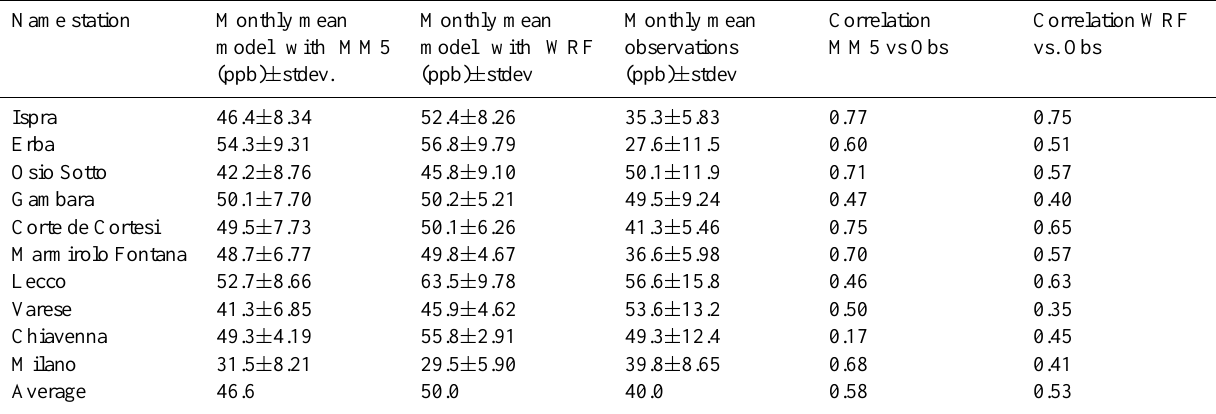
Table 8. Monthly mean ozone values calculated by the CHIMERE model using MM5 and WRF meteorology for June 2005, together with the measurements and the correlation coefficients (based on hourly values), including the standard deviation and the temporal correlation coefficient.